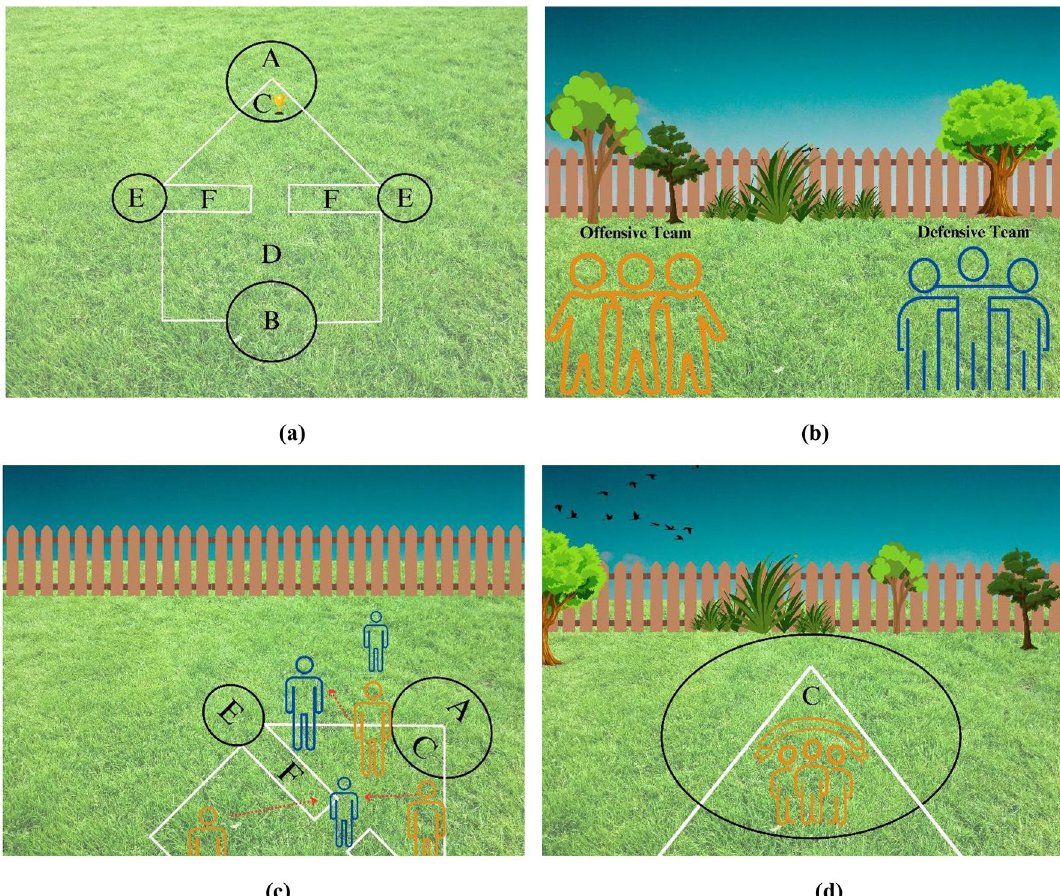
Figure 1. The schematic presentation of Squid